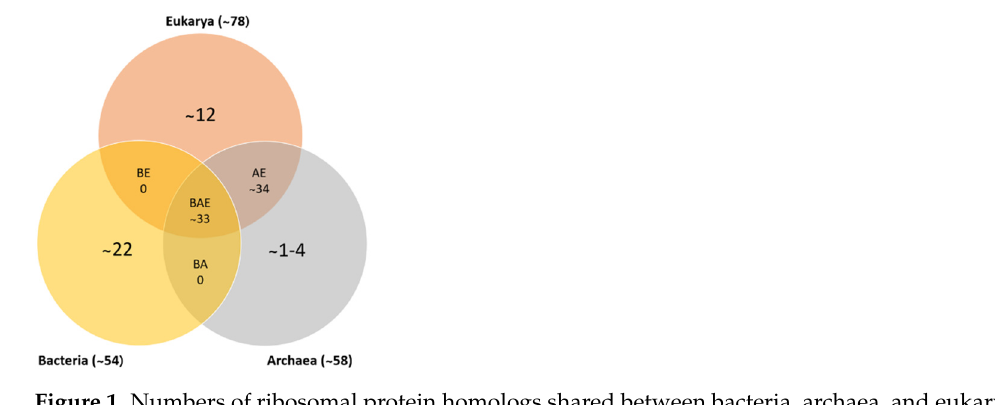
Figure 1. Numbers of ribosomal protein homologs shared between bacteria, archaea, and eukarya (BAE); bacteria and archaea (BA); archaea and eukarya (AE); bacteria and eukarya (BE); or unique (adapted from [10,11]).